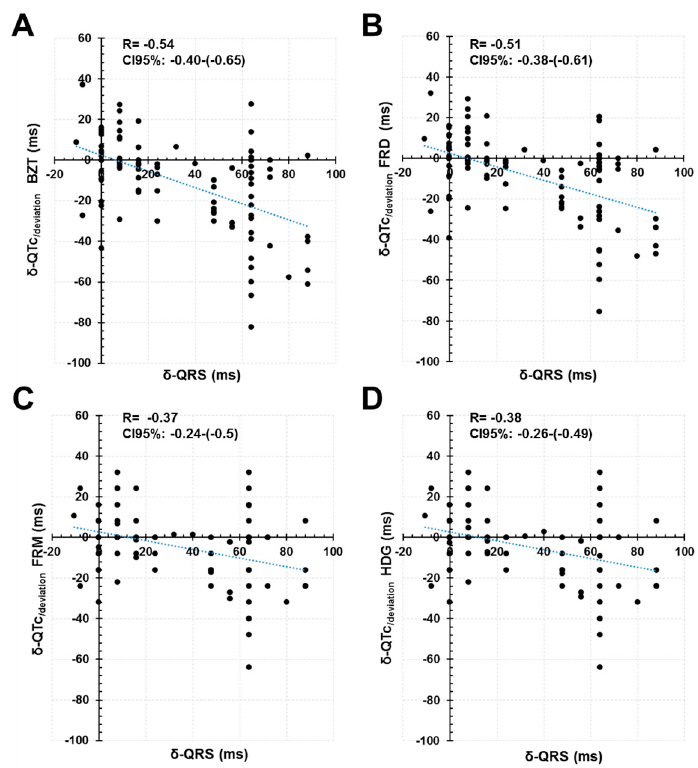
Figure 7. QRS dependence of the δ -QTc / deviation . See text for discussion. BZT: Bazett formula. FRD: Fridericia formula. FRM: Framinghan. HDG: Hodges formula.